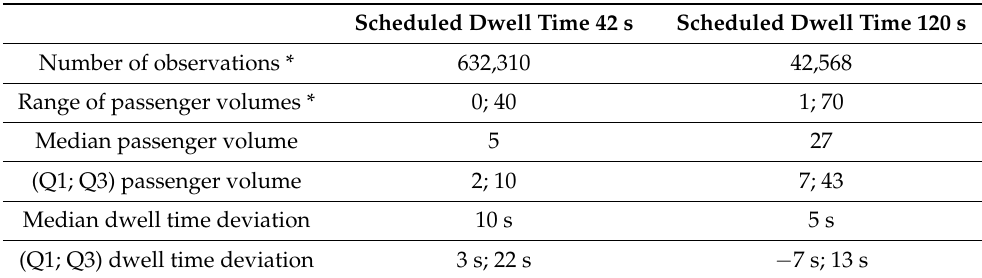
Table 1. Overview of the data.